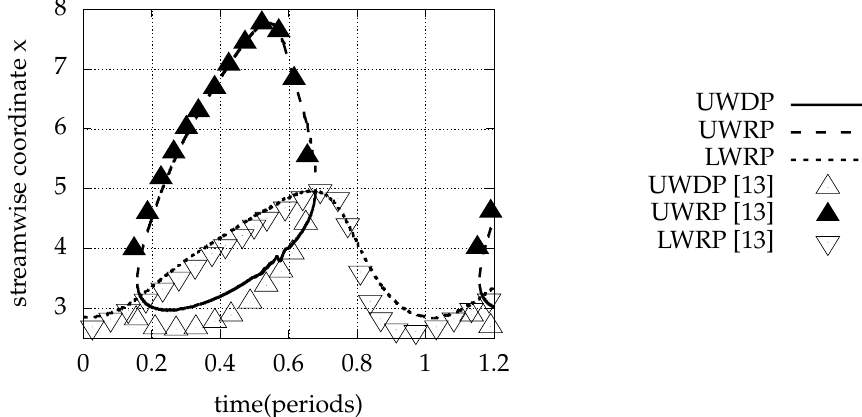
Figure 13. Upper wall detachment position (UWDP) and upper and lower wall reattachment positions (UWRP, LWRP) for unsteady periodic inflow with α = 0.05 and Re = 400 and oscillating part of the bottom wall with ω = 0.05, A = 0.2, l = 10. Comparison with results of Mateescu et al. [13] is